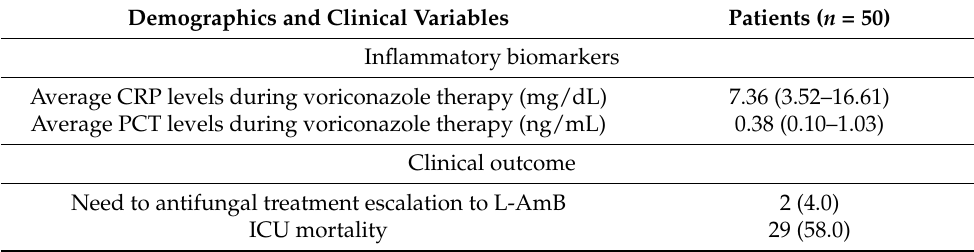
Table 1. Cont. Demographics and Clinical